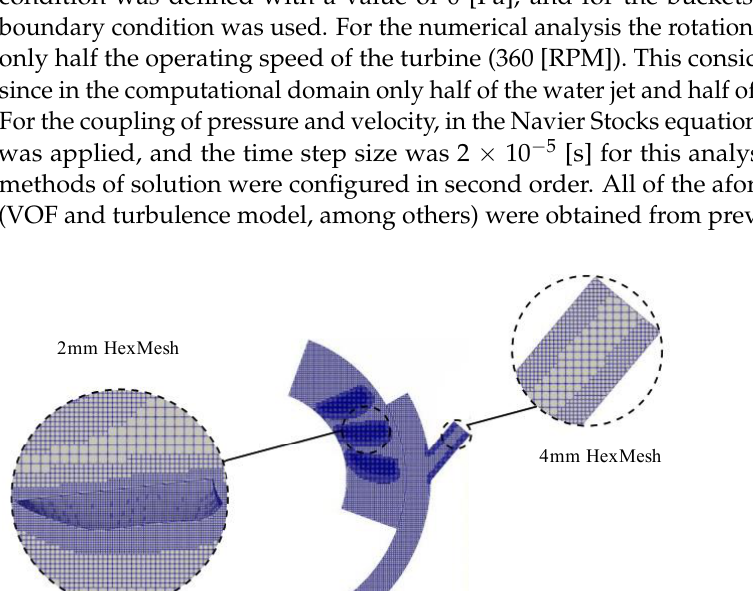
Figure 7. Discretization of computational fluid domain.